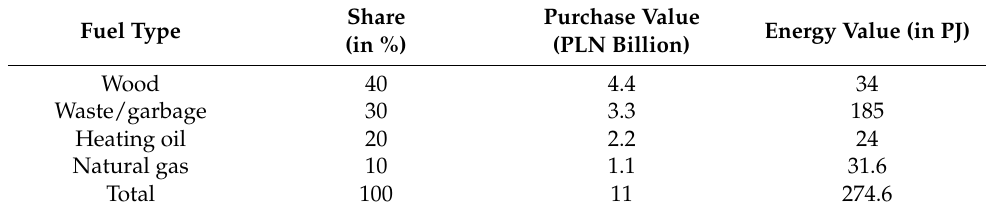
Table 4. Estimation of the energy value for scenario